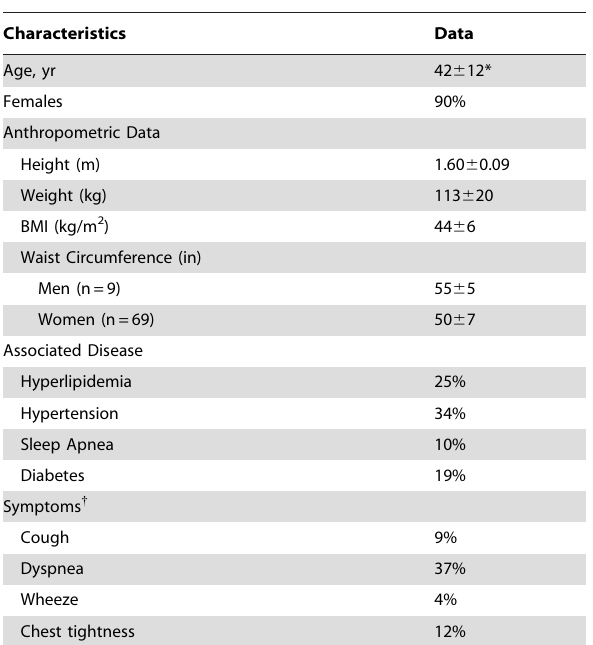
Table 2. Results of spirometry and